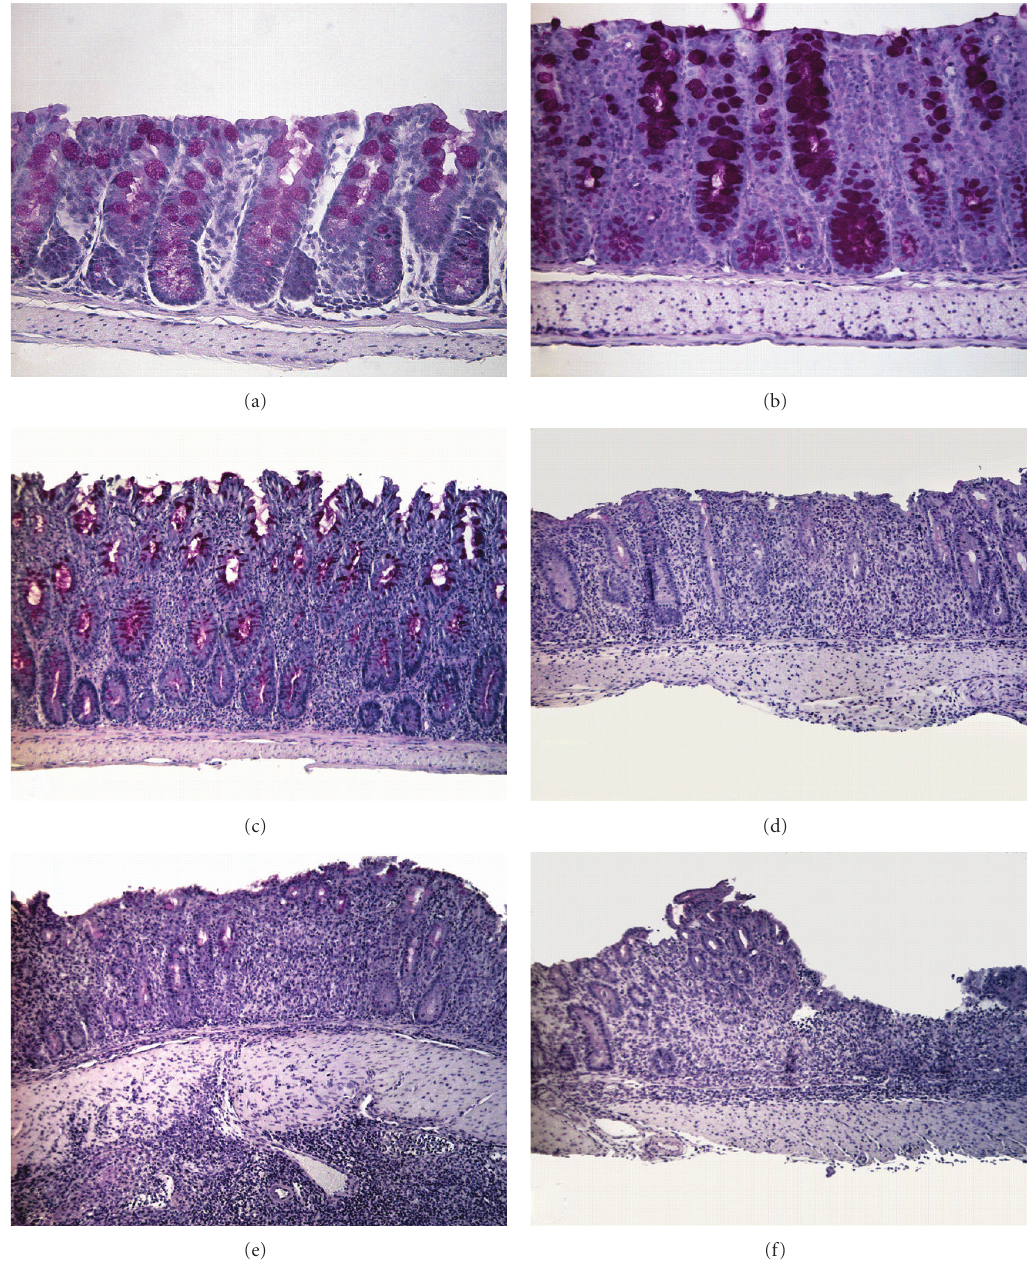
Figure 2: Histological changes in colon after adoptive transfer. Representative photomicrographs of histological changes leading to a progressively higher score from (a) to (f): (a) normal, (b) mild inflammation restricted to the mucosa, (c) moderate mucosal inflammation, (d) severe inflammation extending to submucosa, moderate to severe crypt degeneration, (e) severe transmural inflammation, moderate to severe crypt degeneration, (f) as (e) but with ulceration. Original magnification × 25 for (a-b) and × 10 for